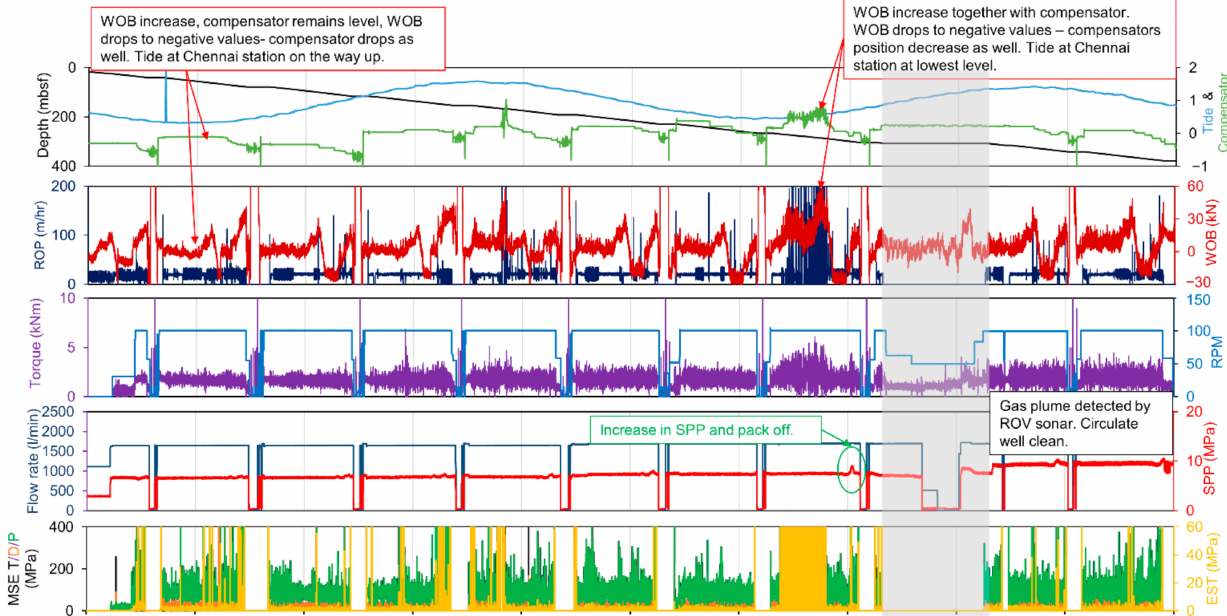
Figure 6. Correlation of sudden changes in WOB with tide and compensator’s position. Time-based drilling parameters and calculated MSE/EST layout. The grey shaded area indicates time spent on circulating wellbore after spotted gas plume by ROV sonar. The green circle and arrow indicate a sudden increase in SPP and